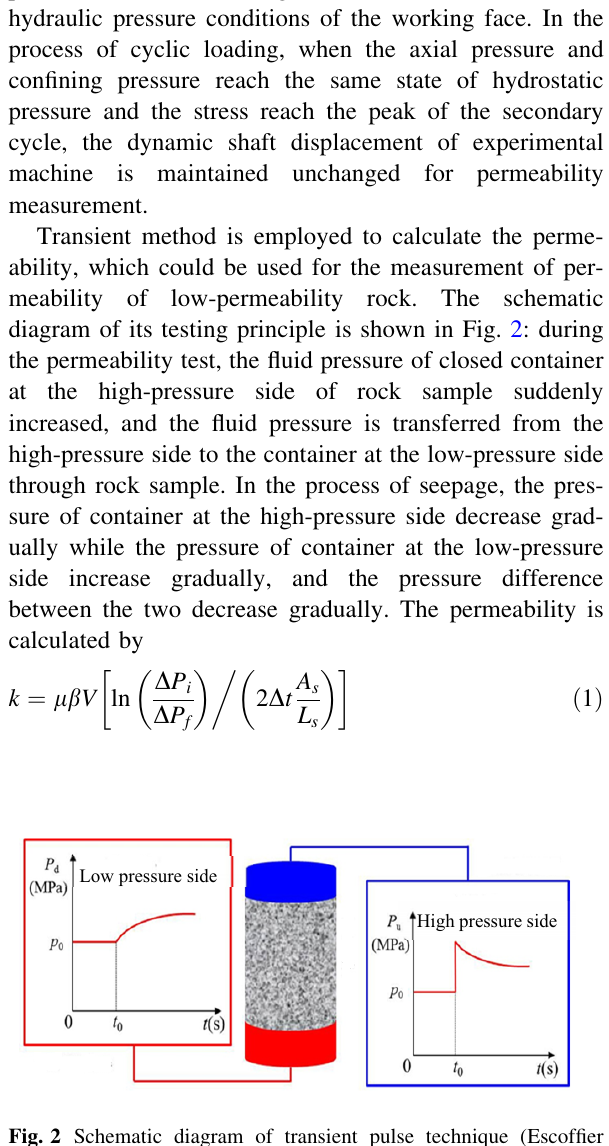
Fig. 2 Schematic diagram of transient pulse technique (Escoffier et al.